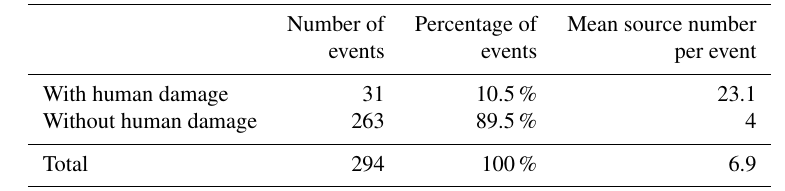
Table 5. Source number related to each event as a function of the presence and absence of human damage (at least one person killed). Only the events for which both the source number and the human damage presence and absence information are known are considered in the counts and for the evaluation of conditional means.